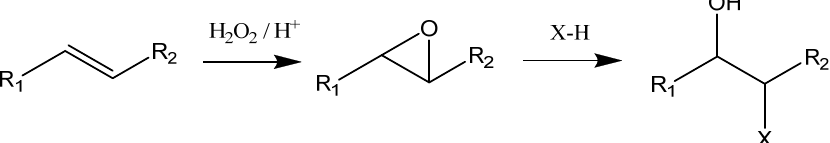
Scheme 3. Epoxidation reaction of vegetable oil followed by oxirane ring-opening.